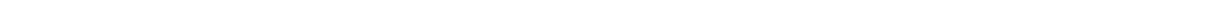
Fig. 1 Expression of EGFL7 by human blood-brain barrier endothelial cells is altered in the CNS of MS subjects. a Expression of EGFL7 (red) by brain vessels (collagen IV, green) in human healthy control (Ctl, temporal), MS active lesion (AL, temporal), MS chronic inactive lesion (CI, temporal) and MS normal- appearing white matter (NAWM, frontal). Nuclei (DAPI) = blue. Representative of n = 5 MS patients and 5 Ctl. Scale bar = 10 μ m. n ≥ 5 sections/subject were analyzed. b – d Semi-quantitative analysis of EGFL7 expression by BBB-ECs as presented in ( a ) according to ( b ) mean pixel intensity, ( c ) relative pixel intensity calculated as mean pixel intensity multiplied by area, and ( d ) area of positive signal for EGFL7 normalized to total vessel area (positive for collagen IV). e , f Expression of EGFL7 (red) in ( e ) areas of perivascular in fi ltration or ( f ) compared to healthy control tissue. CD31 expression (green), nuclei (blue). Scale bar = 50 μ m. g Relative expression of EGFL7 mRNA by ex vivo human leukocytes sorted by CD4, CD8, CD14 or CD19 population, and in human BBB- ECs in primary culture. 1 dot = 1 donor. h Relative expression of EGFL7 mRNA by human BBB-ECs in primary culture in resting (Ctl), in fl amed (TNF + IFN- γ 100 U/ml) or astrocyte-conditioned medium (ACM) conditions. n ≥ 8 different preps per condition. Statistical analysis performed by one-way ANOVA followed by Tukey ’ s multiple comparison test. * p < 0.05. All data presented as mean ± standard error of the mean